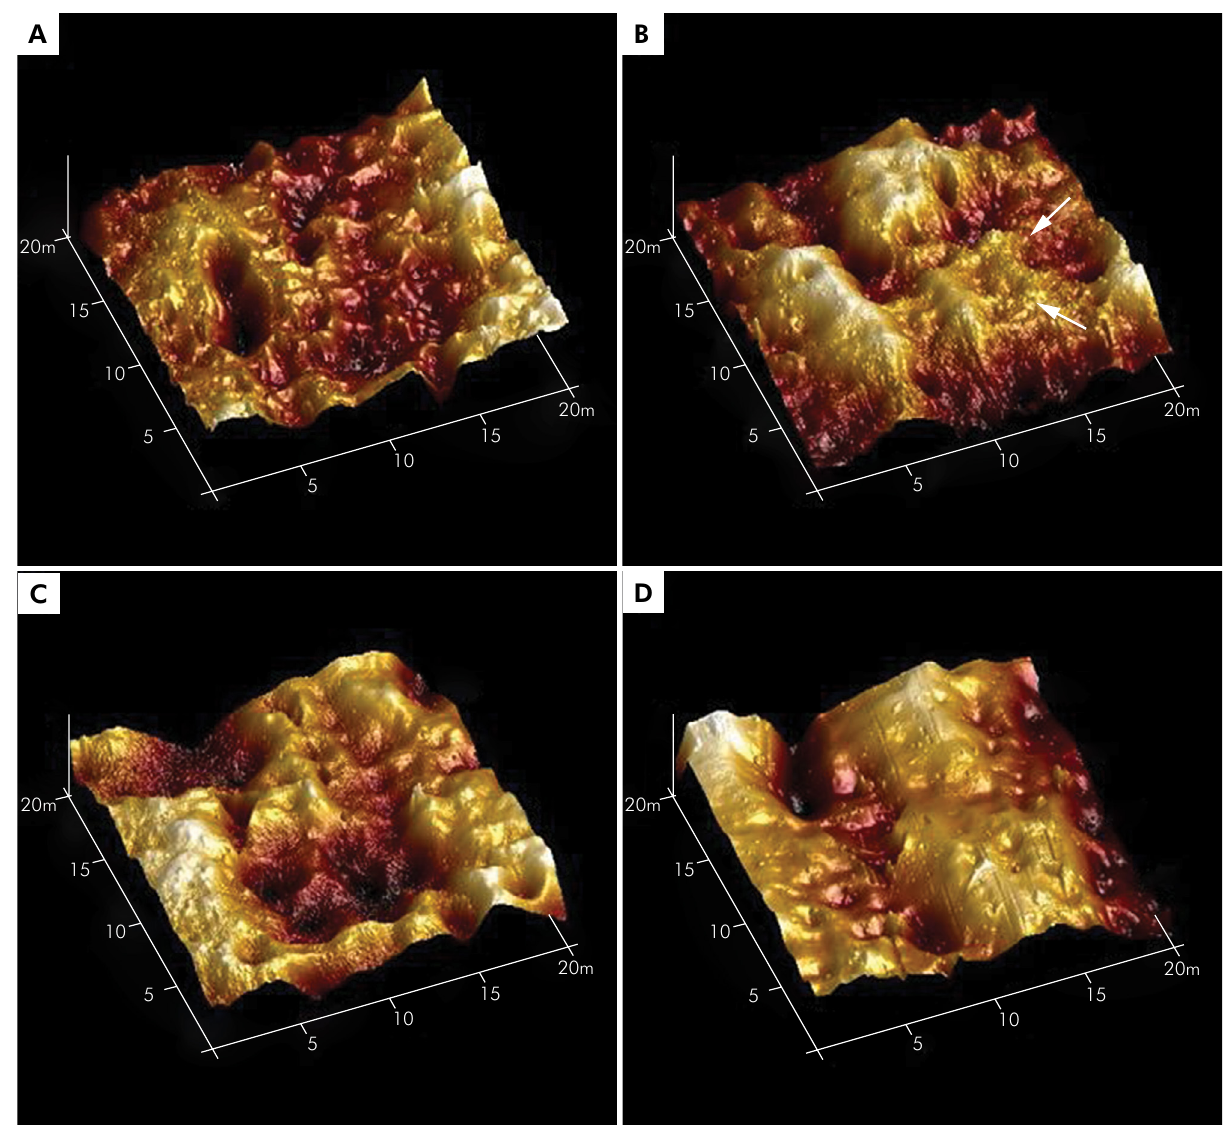
Figure 1. AFM images of orthodontic wires from untreated (a), artificial-saliva (b), CC (c), and EC (d)